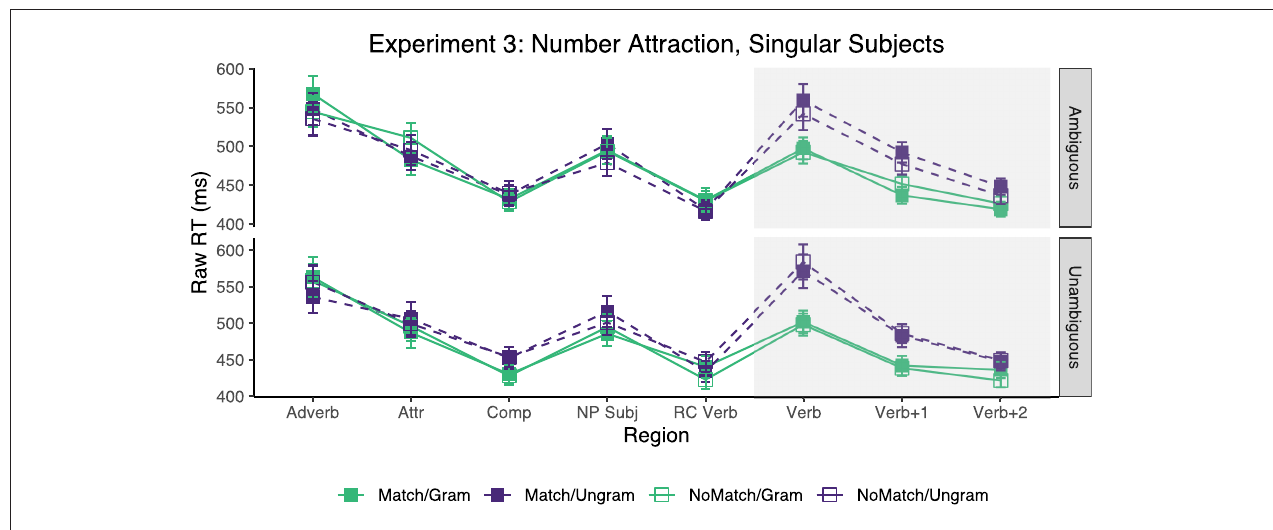
Figure 3 | Mean raw reading times from Experiment 3 for all conditions and regions by attractor AMBIGUITY . Error bars represent the standard error of the condition mean across participant averages.